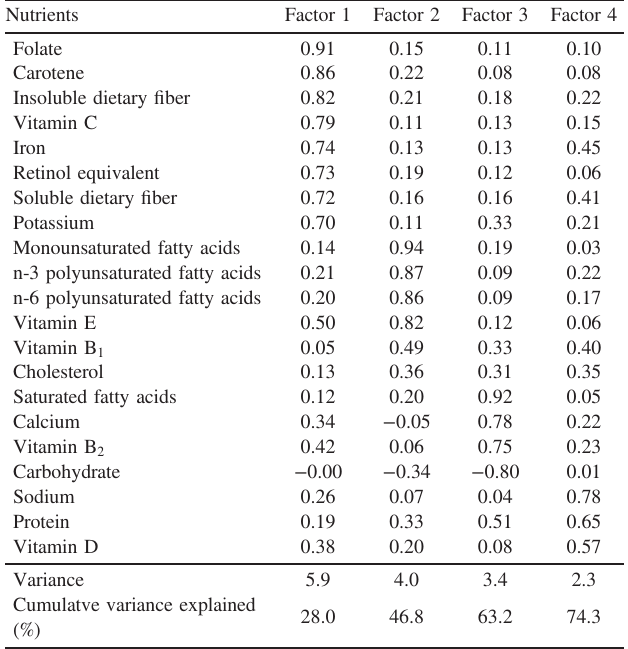
Using factor analysis, four nutrient patterns were extracted (Table 2). Based on the correlation coe ffi cients with nutrient intake, Factor 1 was named “ vitamins, dietary fi ber, iron and potassium pattern ” ; Factor 2 was named fats and fat-soluble vitamins pattern; Factor 3 was named saturated fat, calcium, vitamin B 2 and low carbohydrate pattern; and Factor 4 was named sodium, protein and vitamin D pattern. Factor 1 accounted for the largest proportion of the total variance in the nutritional intake, accounting for 28.0%, followed by the second factor (18.9%), the third (16.3%) and the fourth factor (11.2%). The sex- adjusted means and standard errors of Factor 1 – 4 scores according to the FLI categories are presented in Table 1.